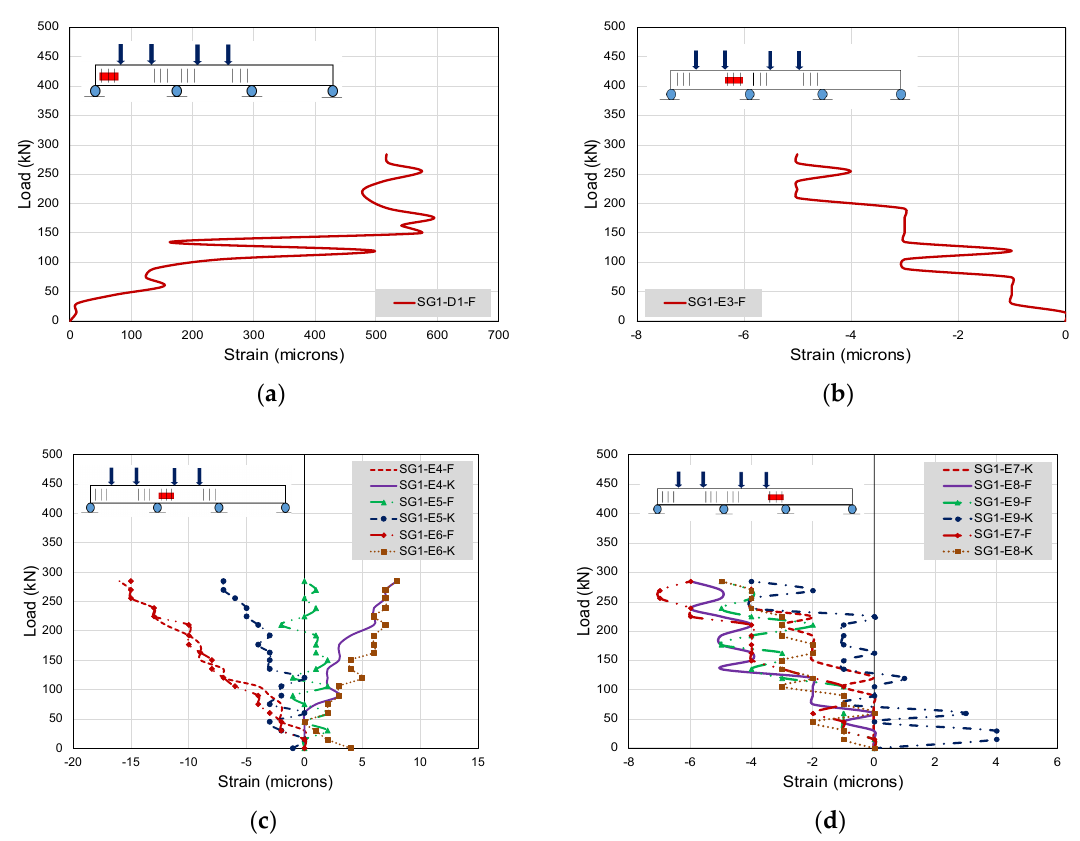
Figure 26. Load versus strain responses in load setup SP-1-L03 ( a ) D1, ( b ) E3, ( c ) E4–E6, and ( d ) E7–E9. Loading Setup SP-1-L04